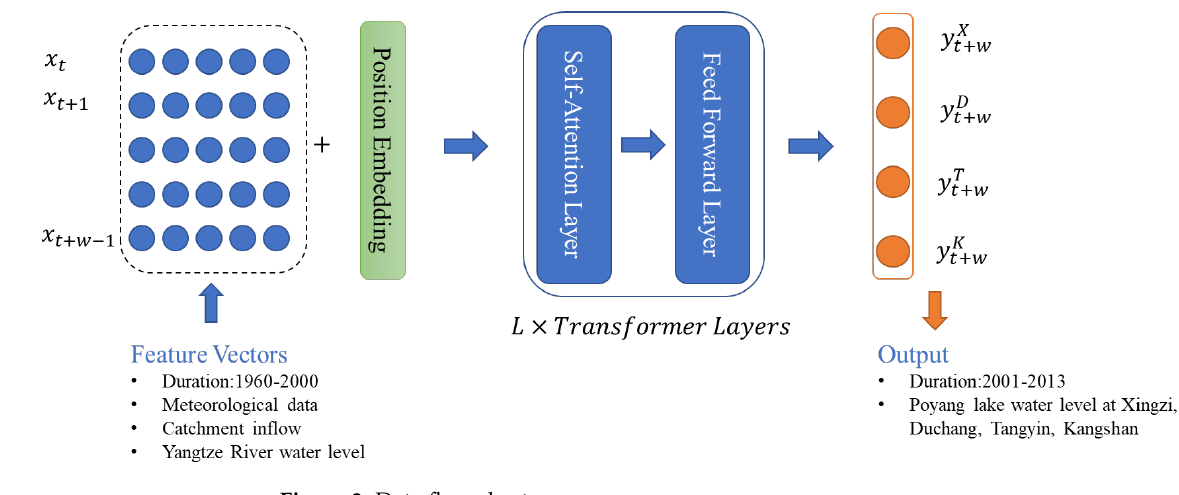
Figure 3. Data flow chart.